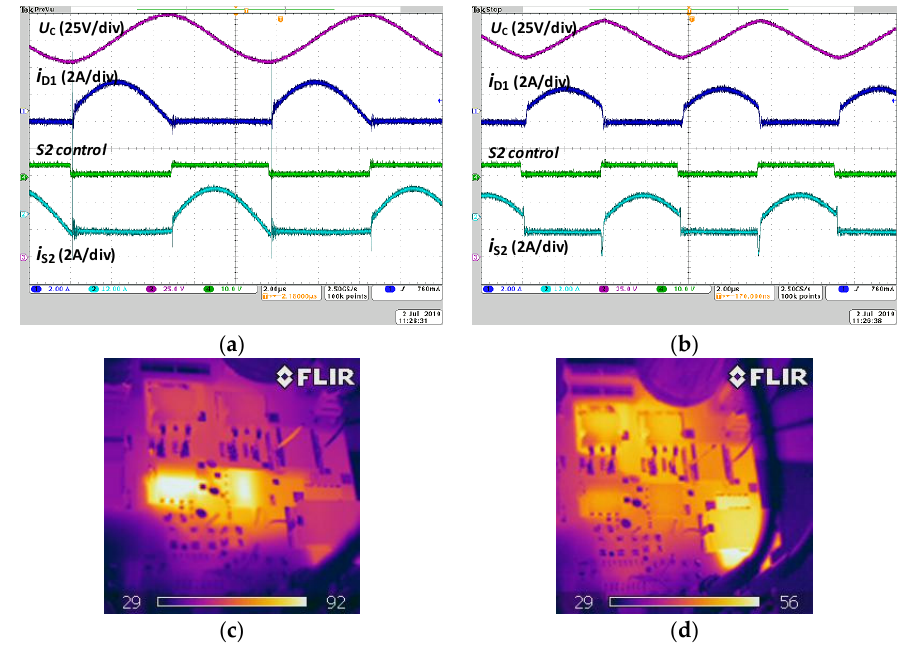
out , ( e ) U out / U in at